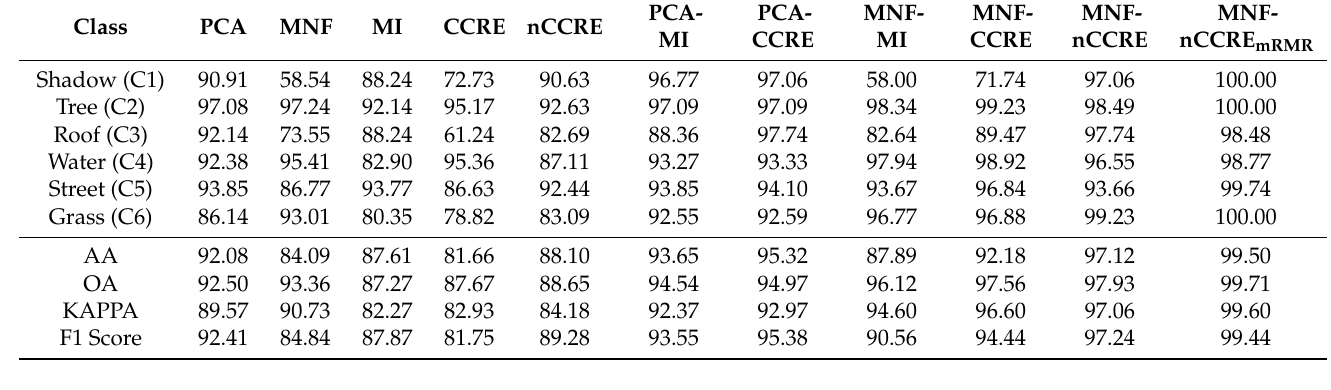
Table 10. Classification performance measure (%) on the HYDICE WDM HSI.